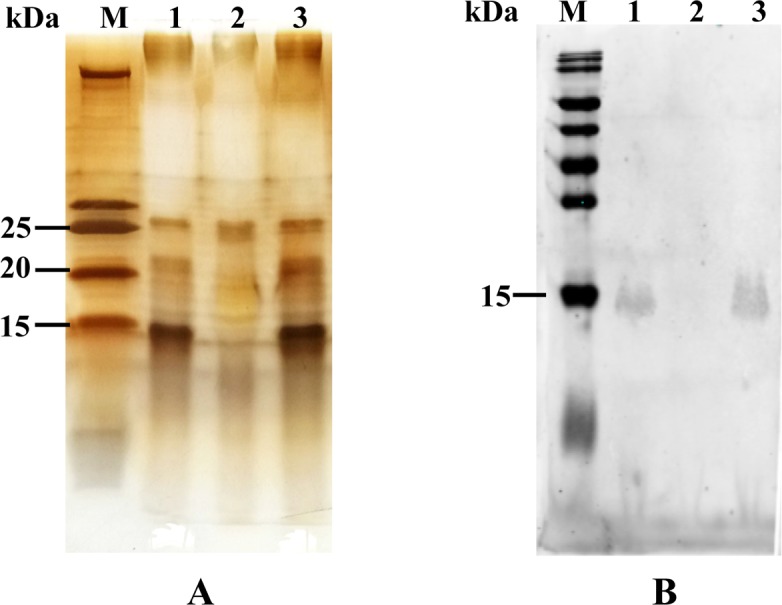
LPS structure analysis.(A) Silver staining of purified LPS. Each lane contained 0.5 μg of purified LPS. Lane M: Prestained Protein Ladder (Thermo Fisher Scientific, Inc.); Lane 1: R. anatipestifer CH3 LPS; Lane 2: The mutant strain RAΔ604 LPS; Lane 3: The complementation strain cRAΔ604 LPS. (B) Western blot analysis. Each lane contained 108−109 CFU of bacteria in 10 μl volume. After SDS-PAGE and transferred to a NC membrane, the NC membrane was incubated with anti-CH3 LPS MAb 1C1 (1:2000 dilution). Lane M: Prestained Protein Ladder (Thermo Fisher Scientific, Inc.); Lane 1: R. anatipestifer WT strain CH3; Lane 2: The mutant strain RAΔ604 LPS; Lane 3: The complementation strain cRAΔ604.